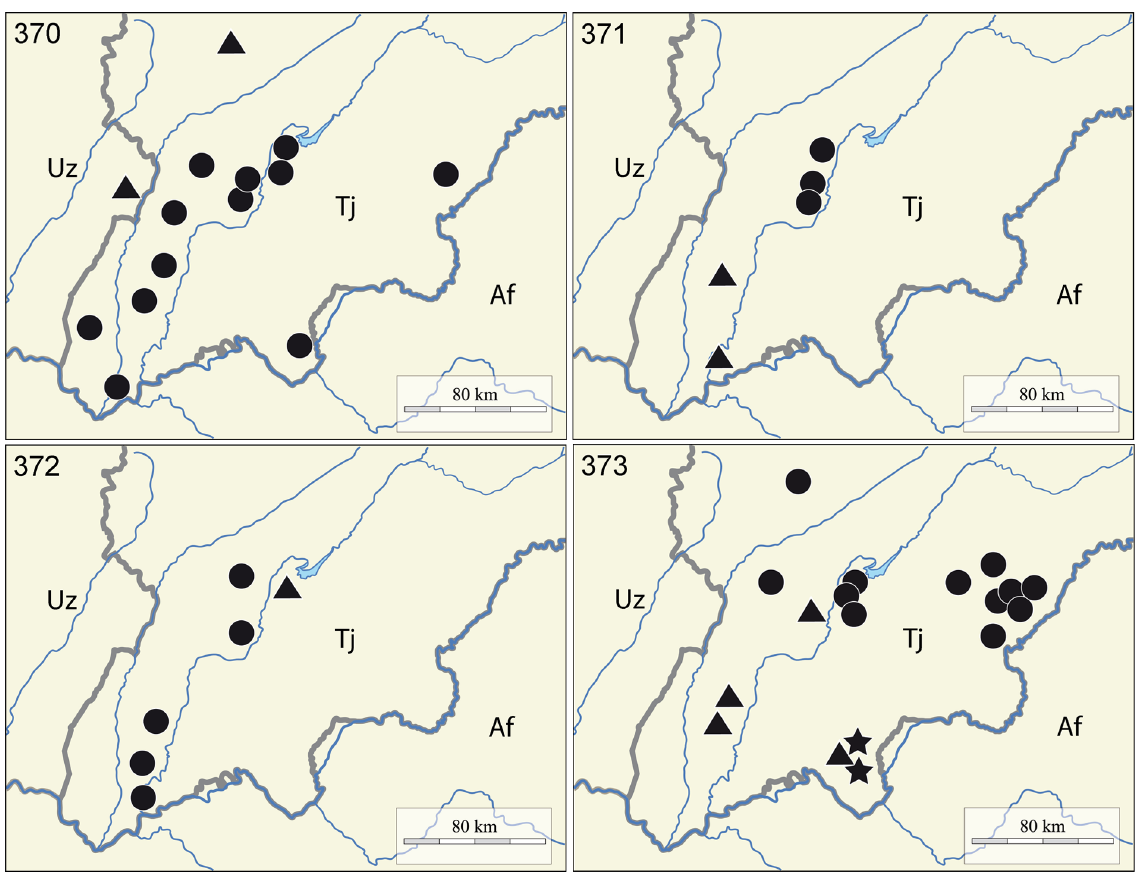
Fig. 370–373. Distribution of Anemesia spp. 370 . Records of A. andreevae sp. nov. ( ) and A. oxiana sp. nov. ( ). Country abbreviations: Af = Afghanistan; Tj = Tajikistan; Uz = Uzbekistan. Fig. 371. Distribution of Anemesia spp. Records of A. castanea sp. nov. ( ) and A. karatauvi (Andreeva, 1968) ( ). Country abbreviations as in Fig. 370. Fig. 372. Distribution of Anemesia spp. of A. sp. nov. ( ) and A. parvula sp. nov. ( ). Country abbreviations as in Fig. 370. Fig. 373. Distribution of Anemesia spp. Records of A. incana Zonstein, 2001 ( ), A. infumata sp. nov. ( ) and A. infuscata sp. nov. ( ). Country abbreviations